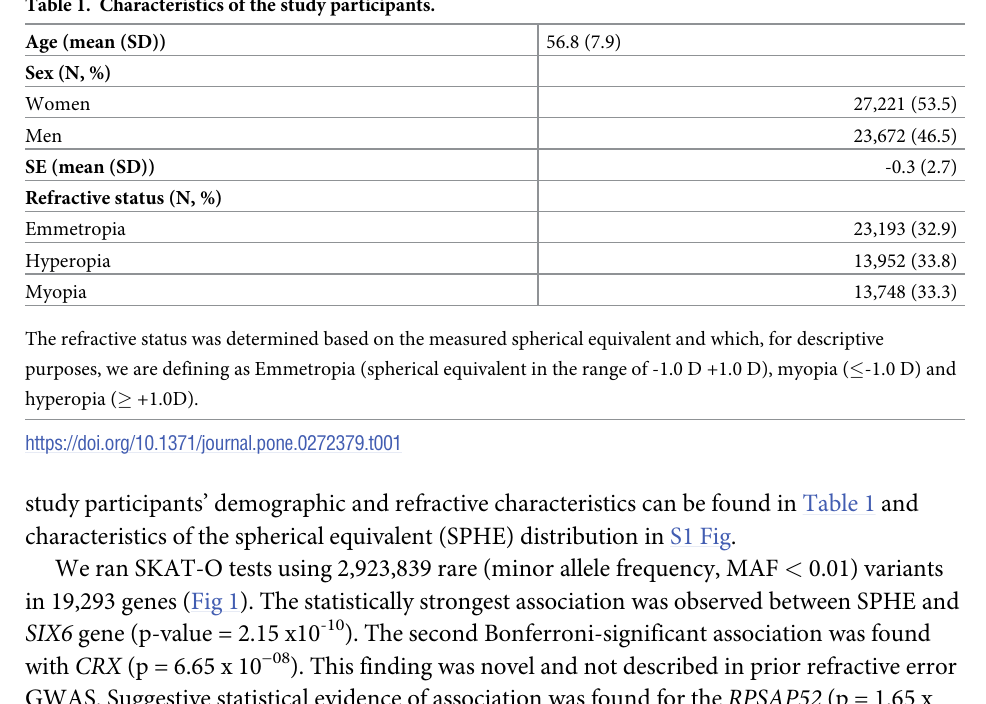
Table 1. Characteristics of the study participants.